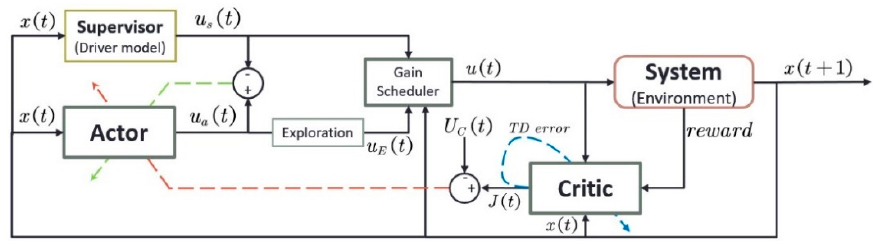
Figure 3. Schematic representation of the SRL-based CACC algorithm.